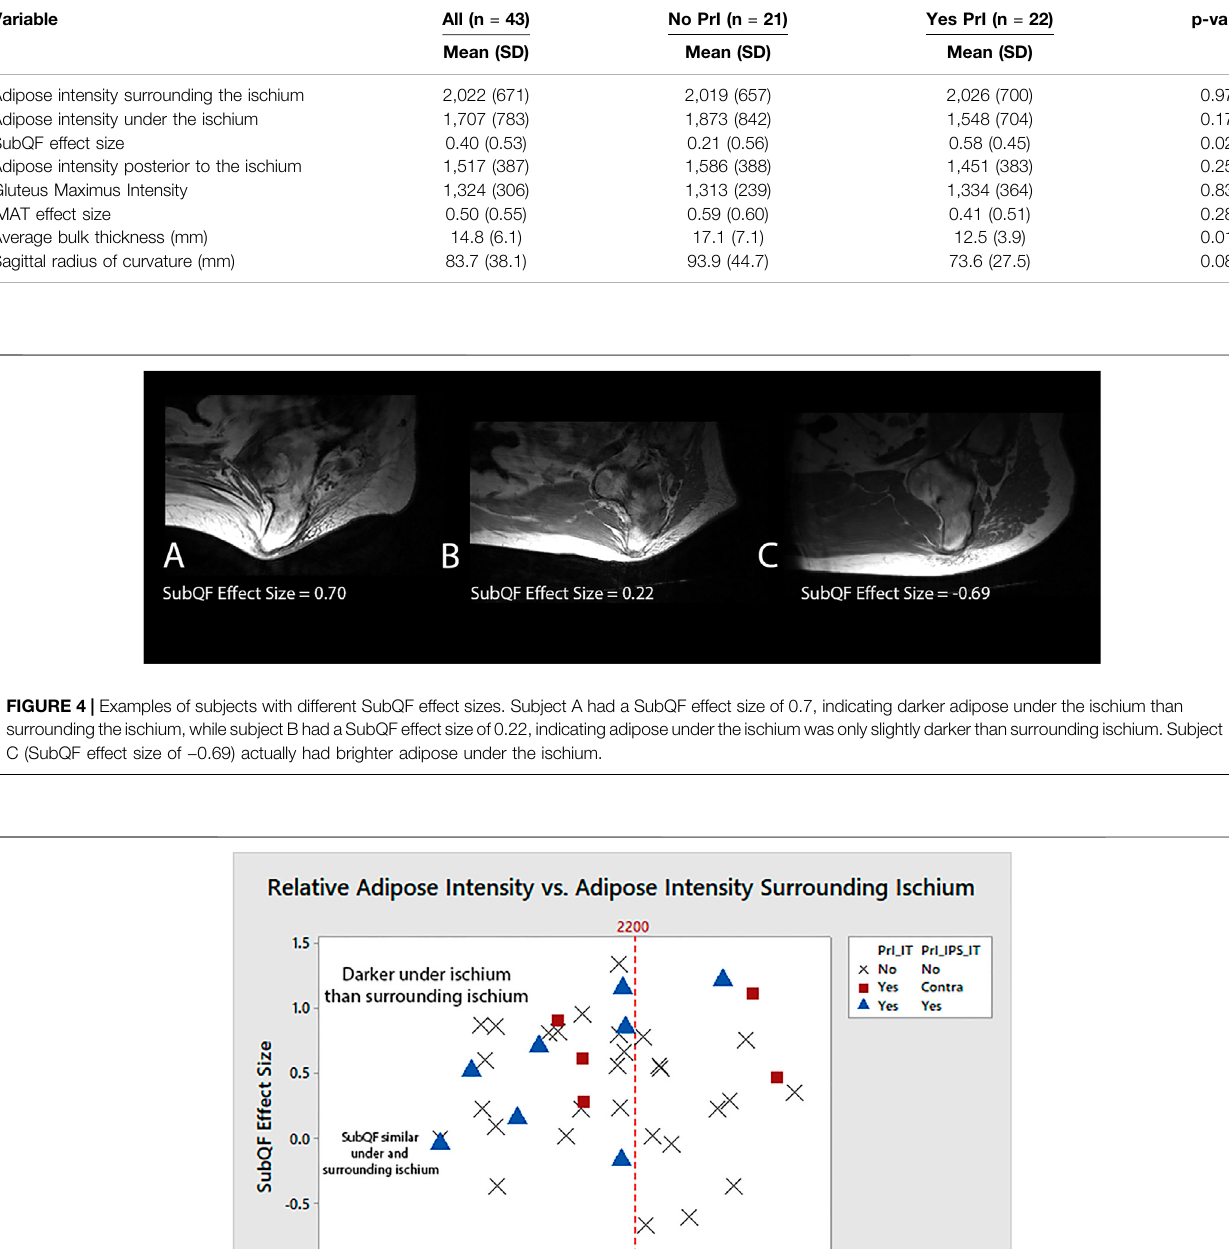
Frontiers in Bioengineering and Biotechnology |